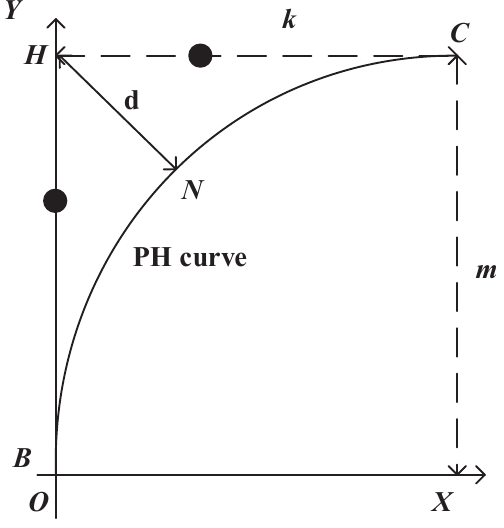
Figure 3. The Pythagorean–Hodograph (PH) curve in the PPO